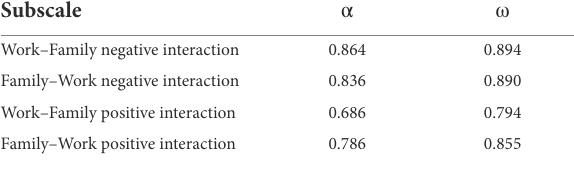
TABLE 3 Internal consistency of the SWING